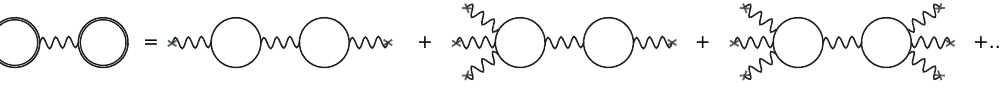
Figure 6 . The weak (cid:12)eld expansion of the reducible contribution to the two-loop spinor EHL. The single photons attached to loops are subtracted by renormalisation. Note that Furry’s theorem (now that the propagators are single-lined, vacuum propagators) implies that only an odd number of low energy photons can be attached to each